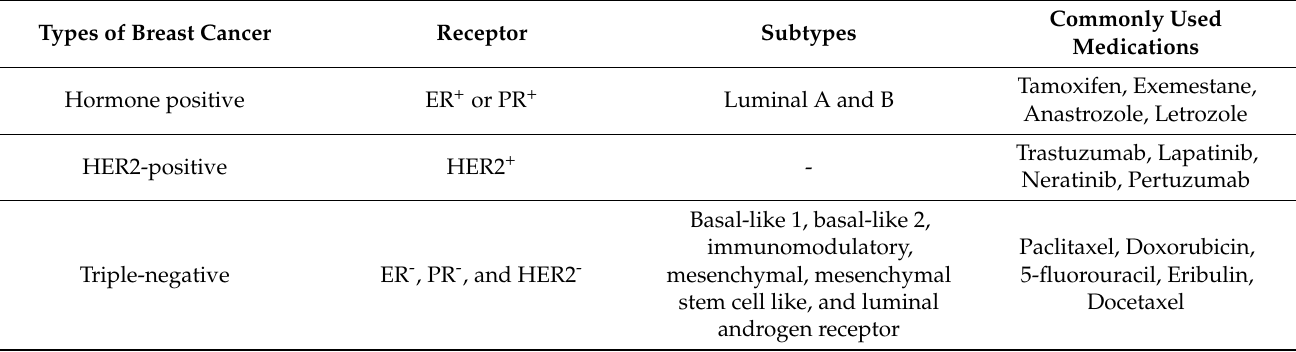
Table 1. Subtypes of breast cancer